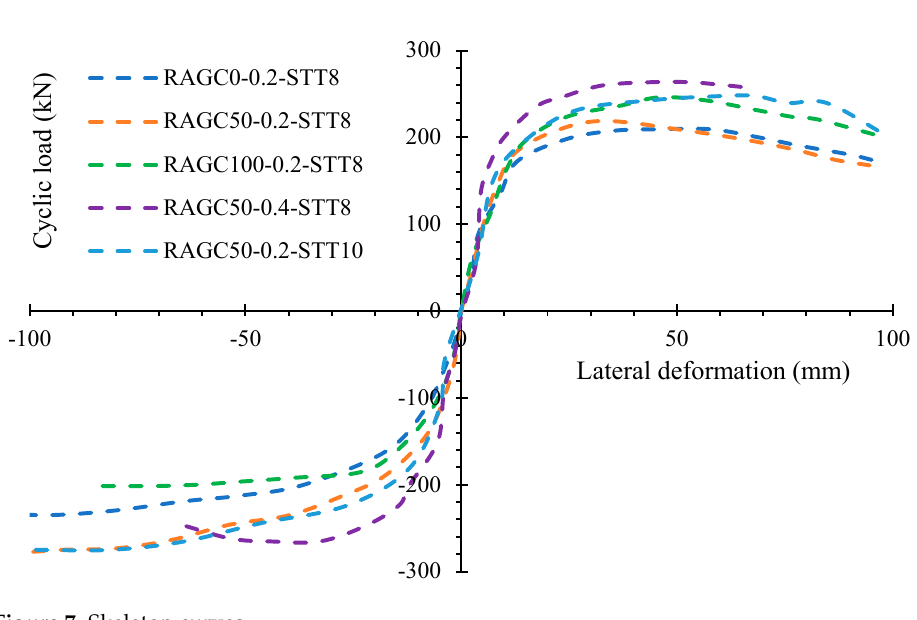
Figure 7. Skeleton curves.